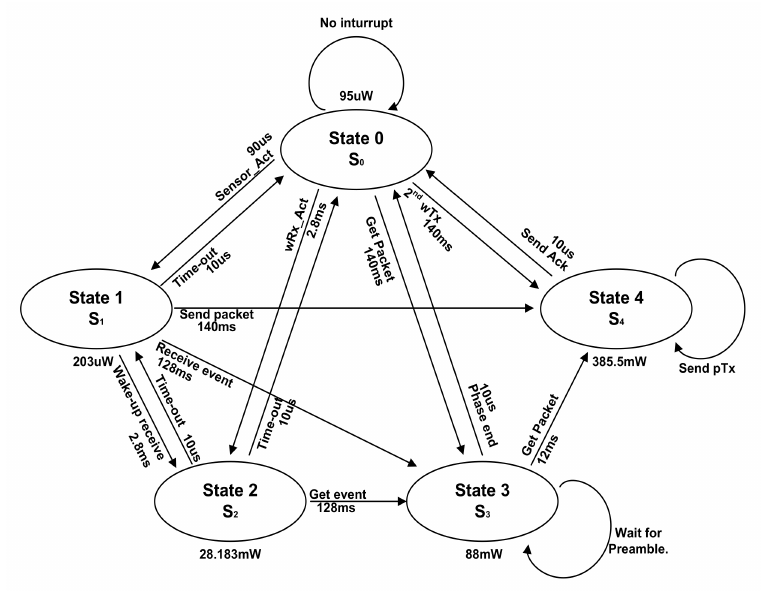
Figure 5. Power mode state transition for fine-grain (with five states) power control on WSN. State 0 is the initial state which is sleep state.